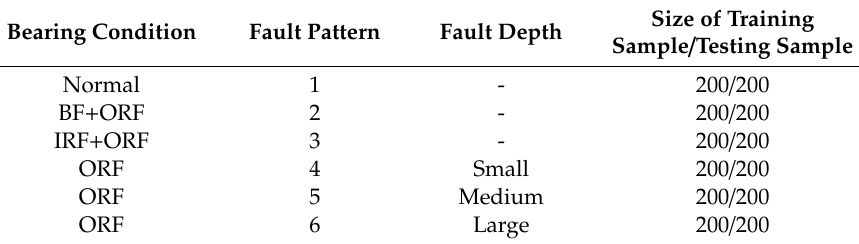
Table 11. Description of the datasets.